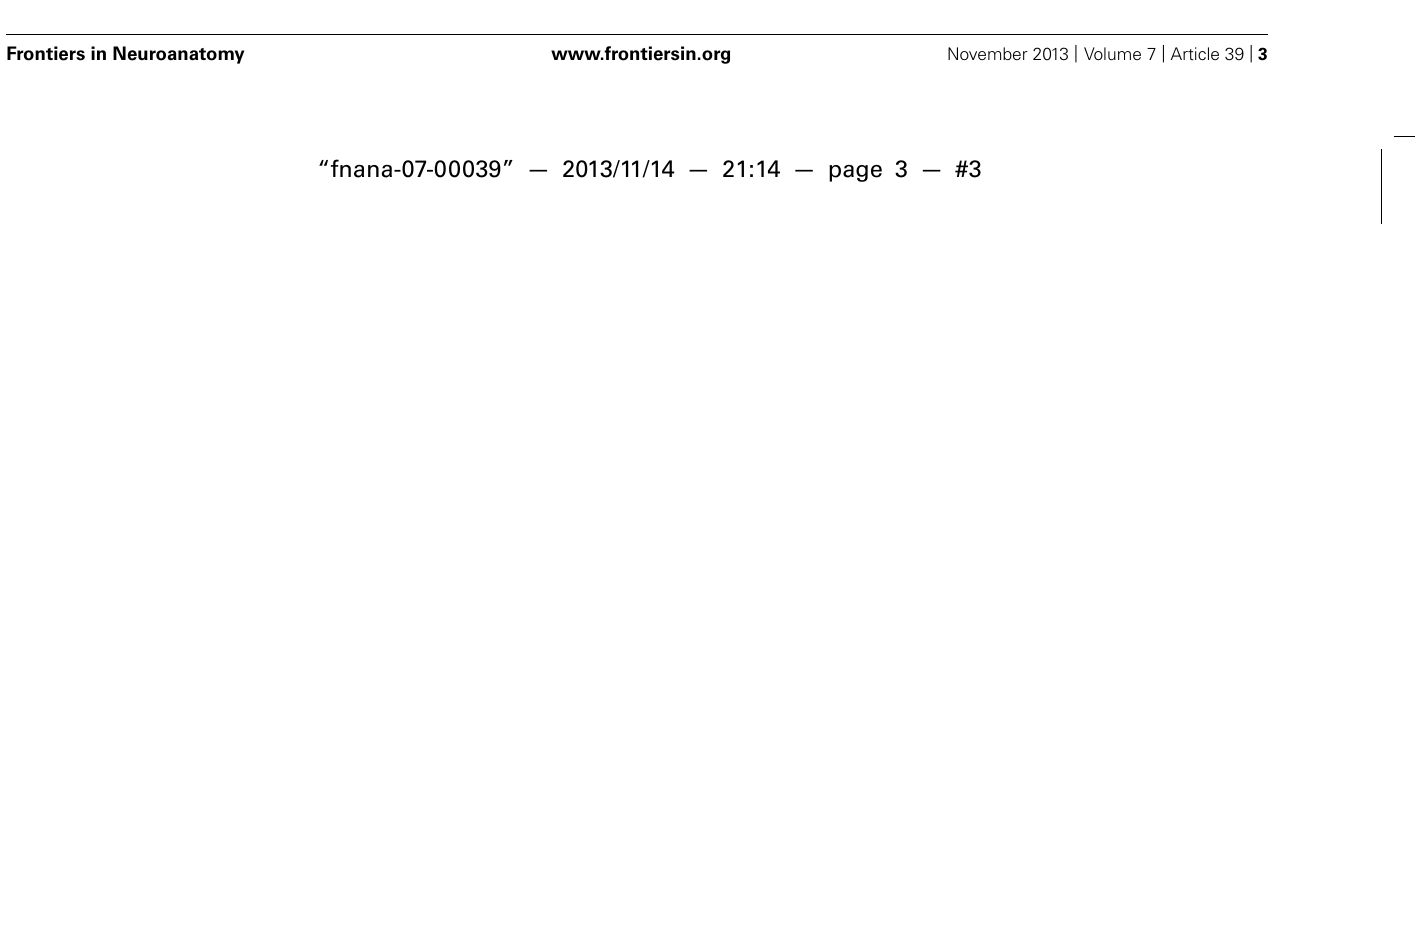
field encompassing both the upper and lower incisors) or the facial vibrissae (92 for the mystacial vibrissae alone, 21 for the mandibular vibrissae alone, and 19 for a receptive field encompassing both the mystacial and mandibular vibrissae). Responses to cutaneous stimulation of the face in addition to stimulation of the supraorbital and genal vibrissae were grouped as “face.” (D) Of the total recording sites from the ansiform lobule alone, a similar distribution of sensory allocation was observed with the mystacial vibrissae and incisors dominating sensory representations. Of the incisor representations, responses stimulation of the lower incisor were particularly